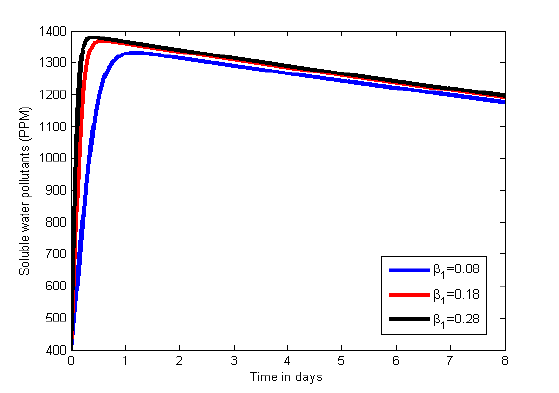
Fig. 2. Effect for the rate of water pollutants which are soluble